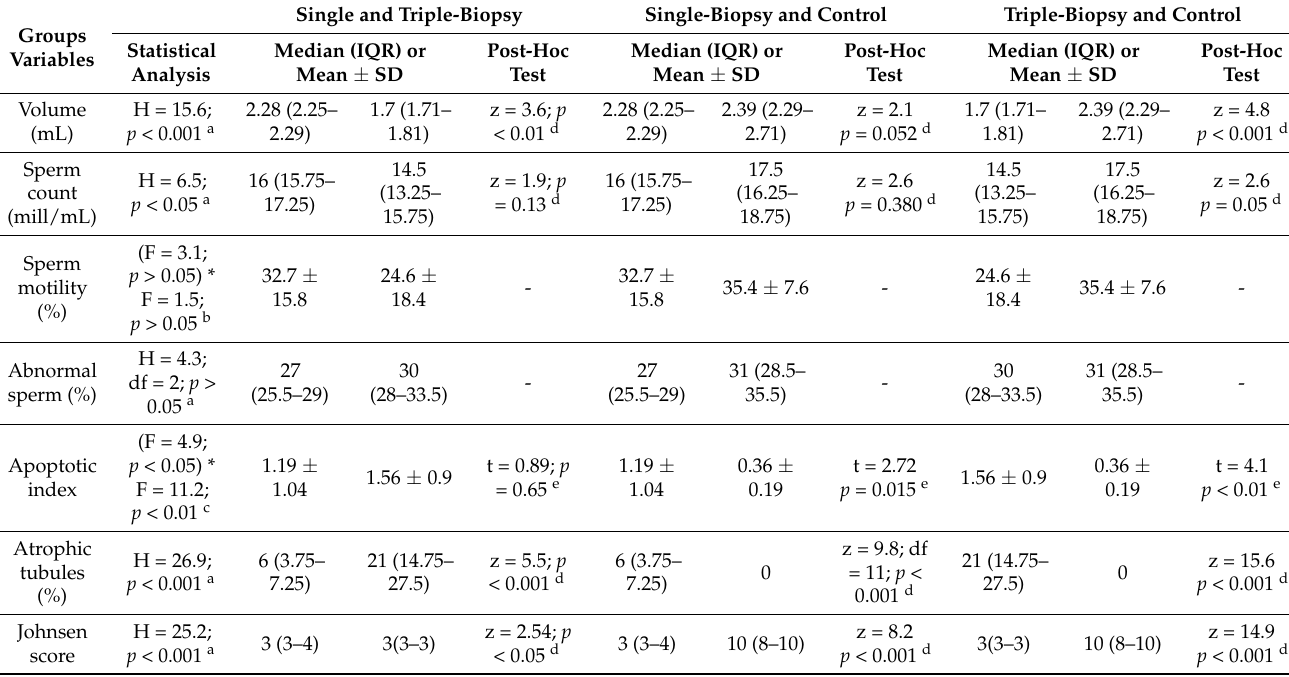
Table 1. Examined variables for left